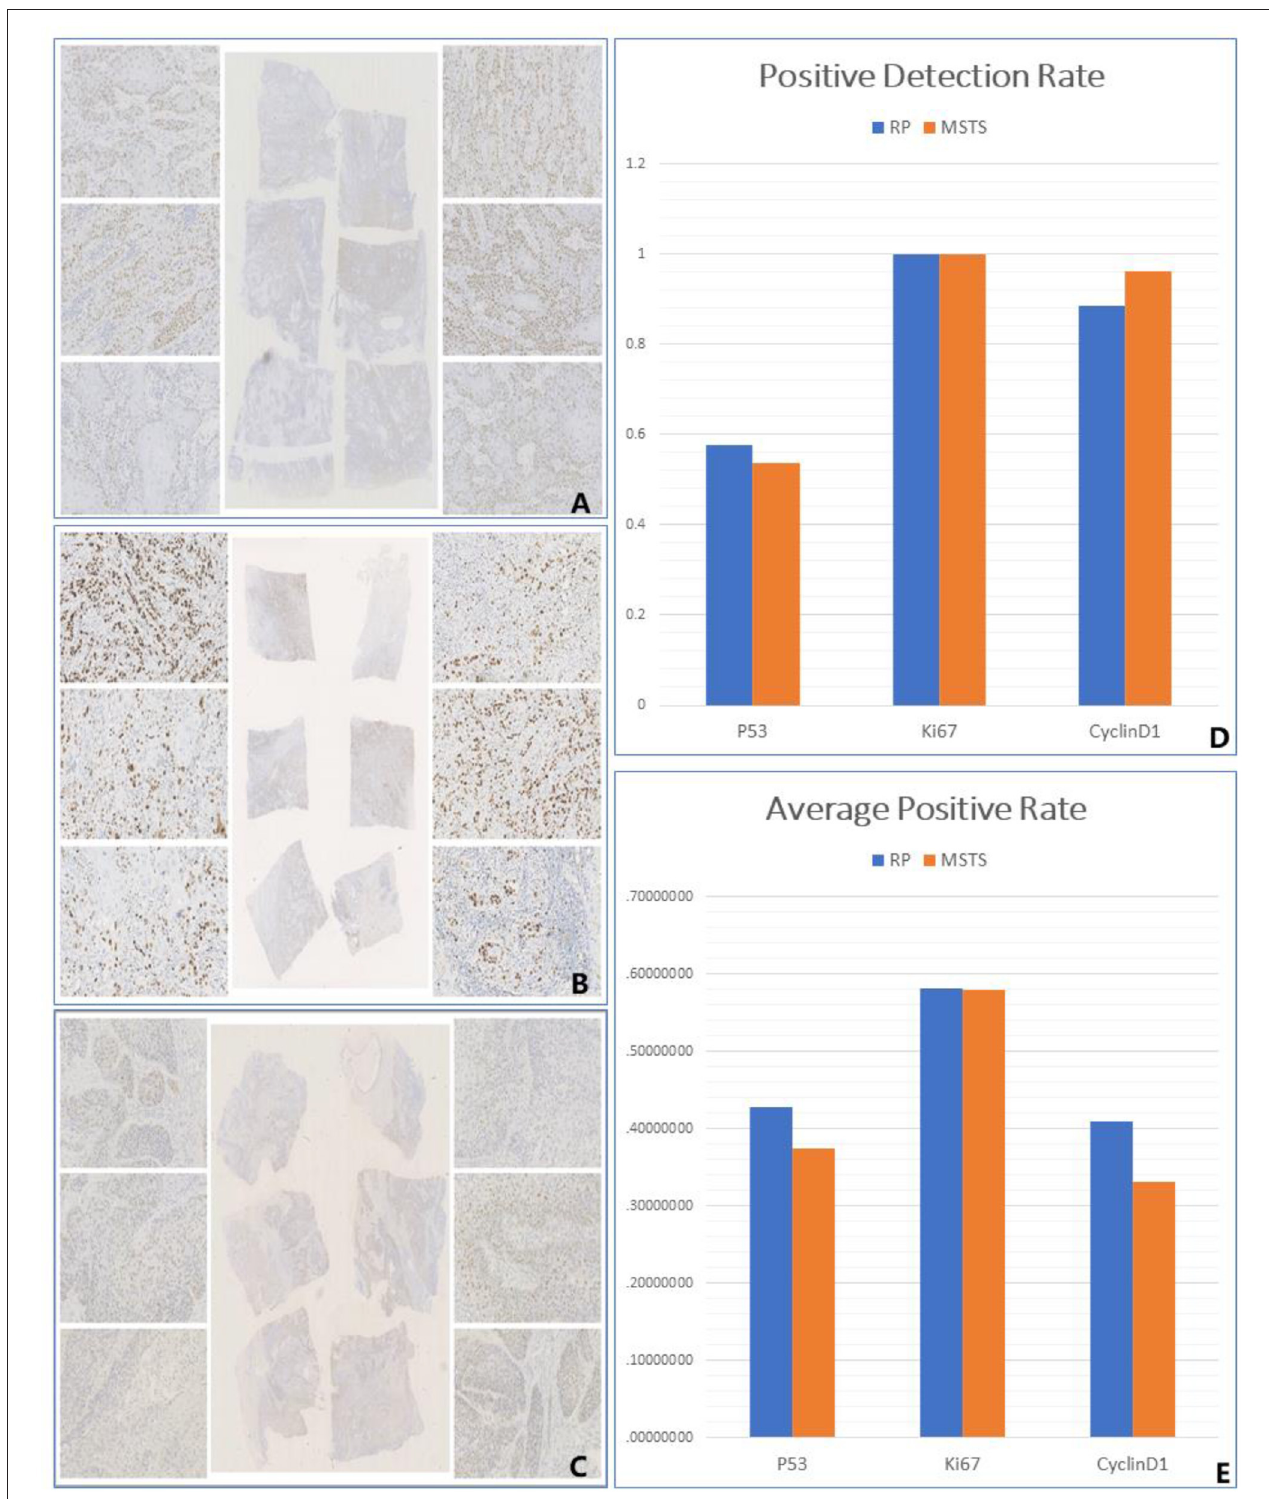
FIGURE 4 | Immunohistology. (A) The differential expression of P53 among different small sampling blocks in the same multi-site sampling block. (B) The differential expression of Ki67 among different small sampling blocks in the same multi-site sampling block. (C) The differential expression of CyclinD1 among different small sampling blocks in the same multi-site sampling block. (D) The positive detection rate of two methods. (E) The average positive rate of two methods.